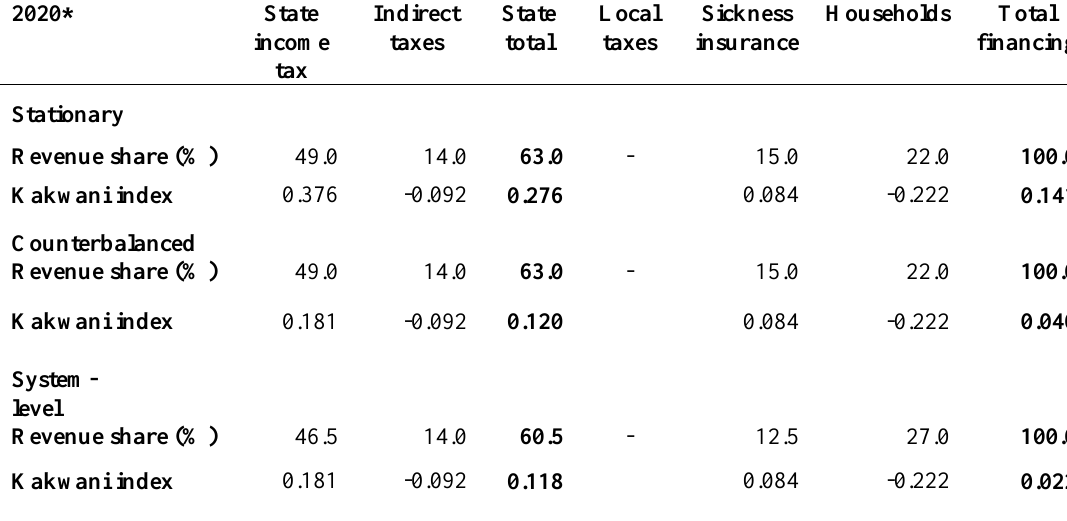
Overall progressivity in various reform